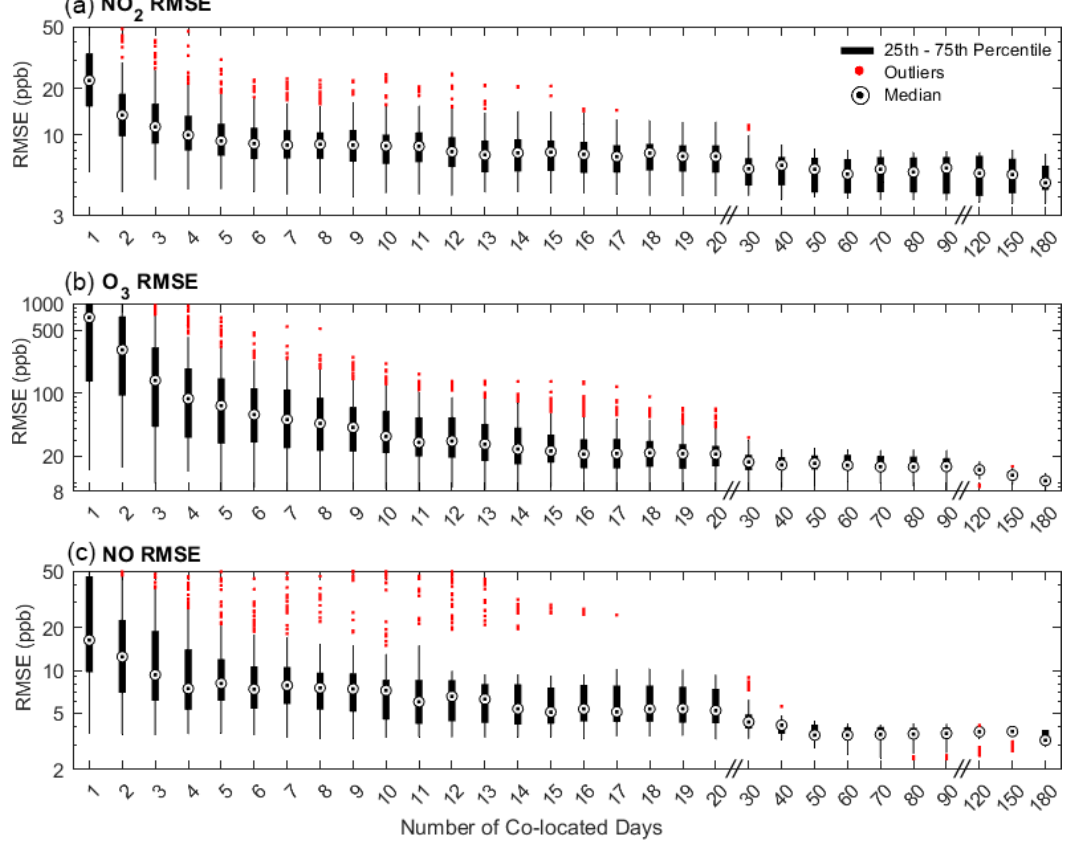
Figure 2. The potential range of RMSE values for a given co-location length for three low-cost sensors (NO 2 , O 3 , and NO). A calibration length of 1d indicates that a random 24h period was selected out of all available days between February 2019 and February 2020. The RMSE for a given test calibration period was determined by comparing the 1h averaged reference and the corrected sensor data associated with that calibration across the evaluation period (all days not included in the calibration period). For each calibration length, 250 randomly selected calibration periods were used to assess the potential RMSE range. All sensors were calibrated using previously identified predictors in a multiple linear regression using data from the calibration period only. The reference NO 2 concentrations ranged between 1 and 58ppb over the full year, with a median concentration of 5ppb, the reference O 3 concentrations ranged between 1 and 110ppb, with a median concentration of 31ppb, and the reference NO concentrations ranged between 0.1 and 137ppb, with a median concentration of 0.5ppb. Table 2. The median and range (1st–99th percentile) of correlation coefficients ( r ) from 250 calibration runs from six co-location